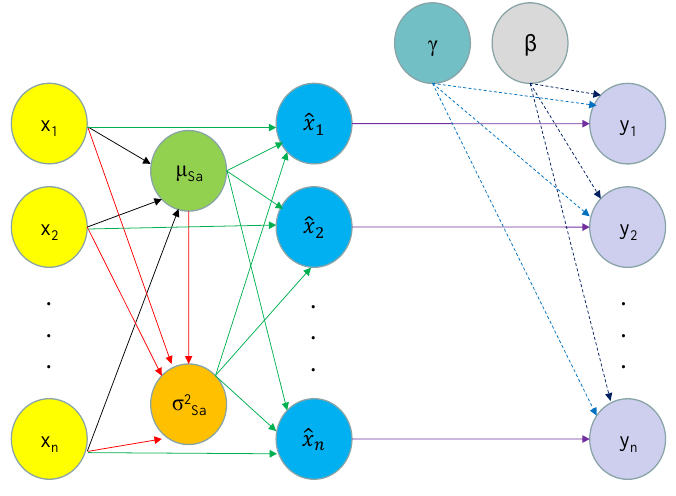
Figure 6. BN layer structure.